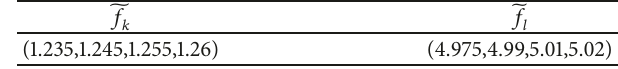
Table 7: The fixed opening cost ( ×10 6 yuan).